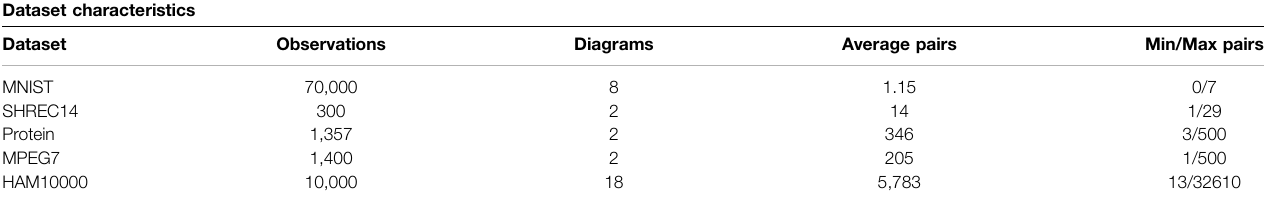
TABLE 3 | Characteristics of each dataset. The column headings can be explained as such: Observations — number of observations in the dataset, Diagrams — the number ofhomologicaltypesusedtocomputepersistencediagrams,AveragePairs — theaveragenumberofbirth/deathpairsacrossthesetofpersistencediagramsforasingle observation in the original dataset, and Min/Max Pairs — the minimum and maximum number of birth/death pairs across the set of persistence diagrams for a single observation in the original dataset. Dataset